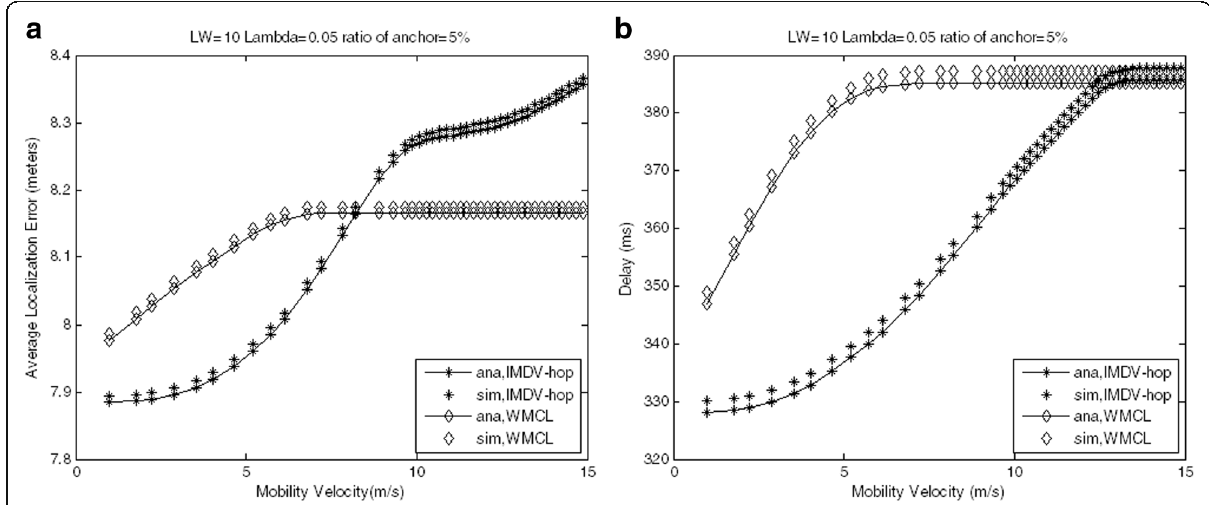
Fig. 13 a Localization error comparison based on mobility velocity. b Localization delay comparison based on mobility